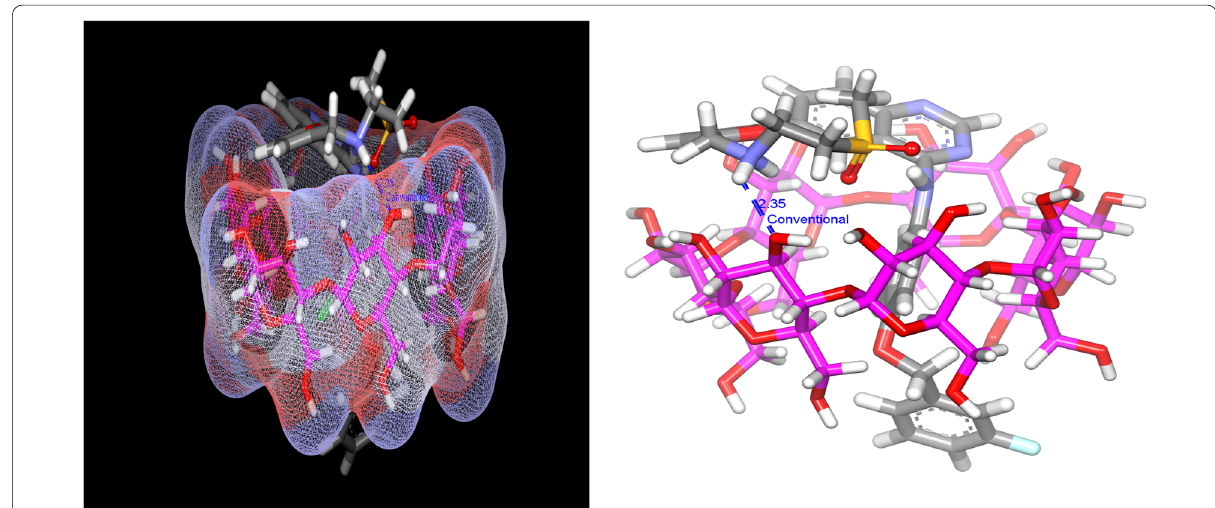
Fig. 13 Binding mode of the Lapatinib ditosylate binary inclusion complex from side [Ball and stick model of LD (gray color) and Wire-mesh model of β-CD] and Binding pose of LD with β-CD. [Ball and stick model of LD (gray color) β-CD (pink